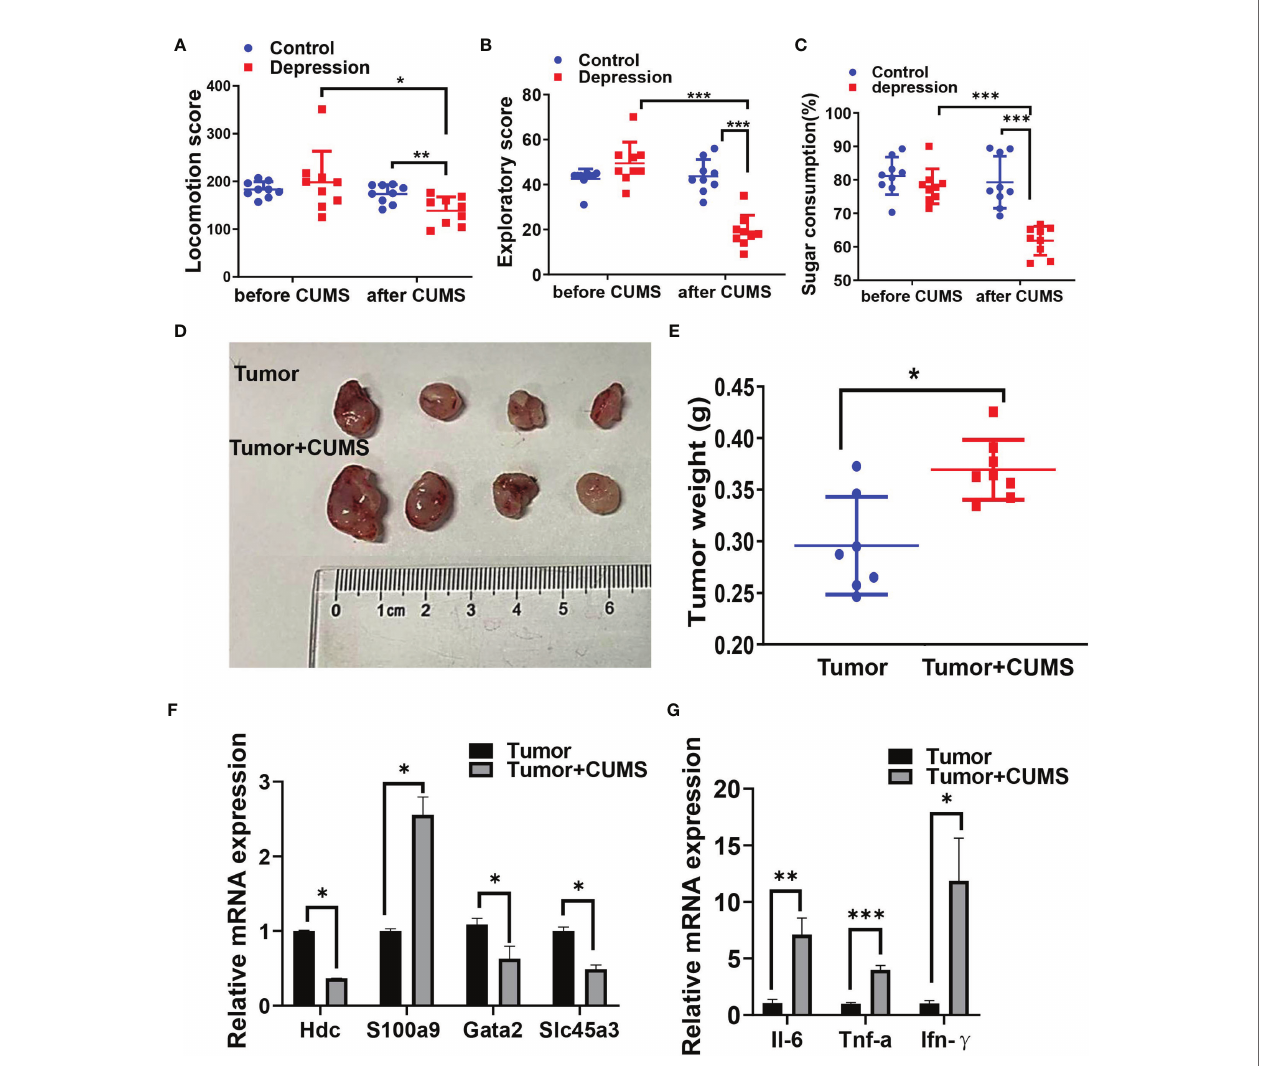
FIGURE 8 | CUMS promotes tumor growth in vivo. Locomotion score (A) and exploratory score (B) of mice expose (or not) to CUMS. (C) Sugar consumption of mice in two groups exposed (or not) to CUMS. (D, E) The tumor-growth promotion effect of CUMS was compared between tumor and tumor + CUMS mice engrafted with LLC (n = 9 for each group). (F) Cancer-associated gene levels between the two groups by qRT-PCR. (G) Proin fl ammatory factor levels between the two groups by qRT-PCR. * p < 0.05, ** p < 0.01, *** p <